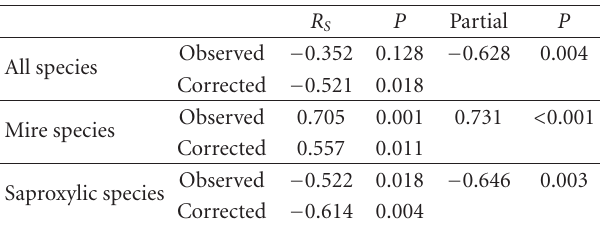
Table 3: Spearman’s correlations between provincial species rich- ness (observed and corrected) and latitude (N coordinates of the provinces). Correlation coe ffi cients and associated P values are given for all species, mire-dwelling species, and saprox- ylic/fungivorous species. Partial correlation coe ffi cients and P val- ues are given for observed species richness and latitude, controlling for per province Malaise trapping e ff ort (see Table